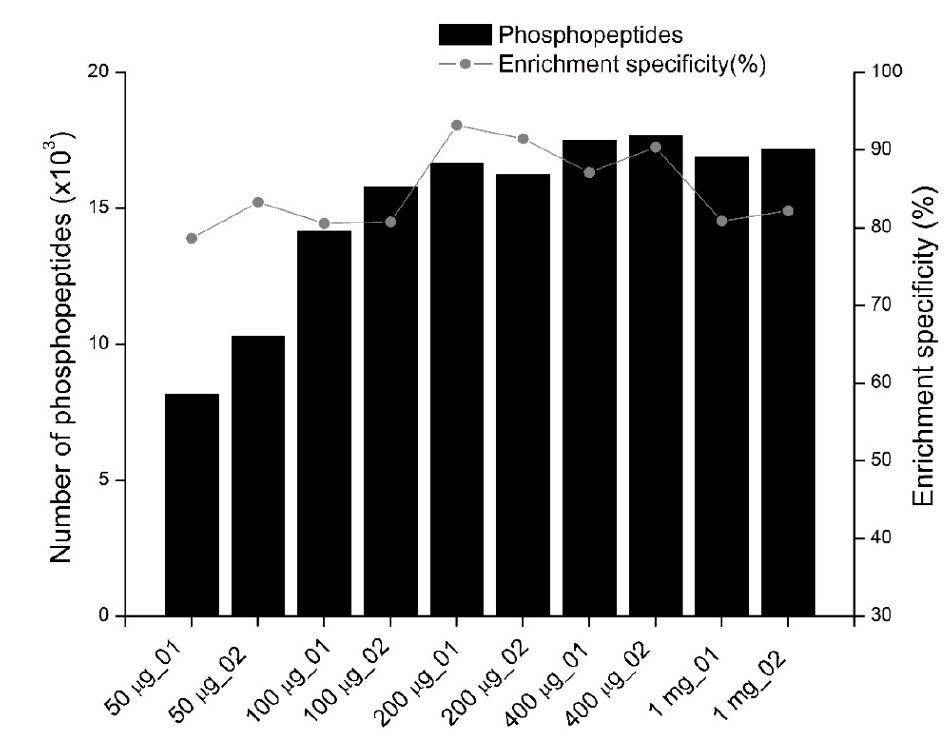
Figure 1. The profiles of phosphopeptides identified from samples in which different amounts of peptides are used for phosphopeptide enrichment. The bar and the curve indicate the number of phosphopeptides identified and the phosphopeptide enrichment specificity (the number of phosphopeptides identified divided by the total peptides identified in each experiment), respectively. The x -axis shows the amounts of peptides used for phosphopeptide enrichment. Two replicates are performed for each condition. For all experiments, phosphopeptides are purified with TiO 2 using lactic acid as a non-phosphopeptide excluder. Table 1. List of solvents used for phosphopeptide enrichment in the four